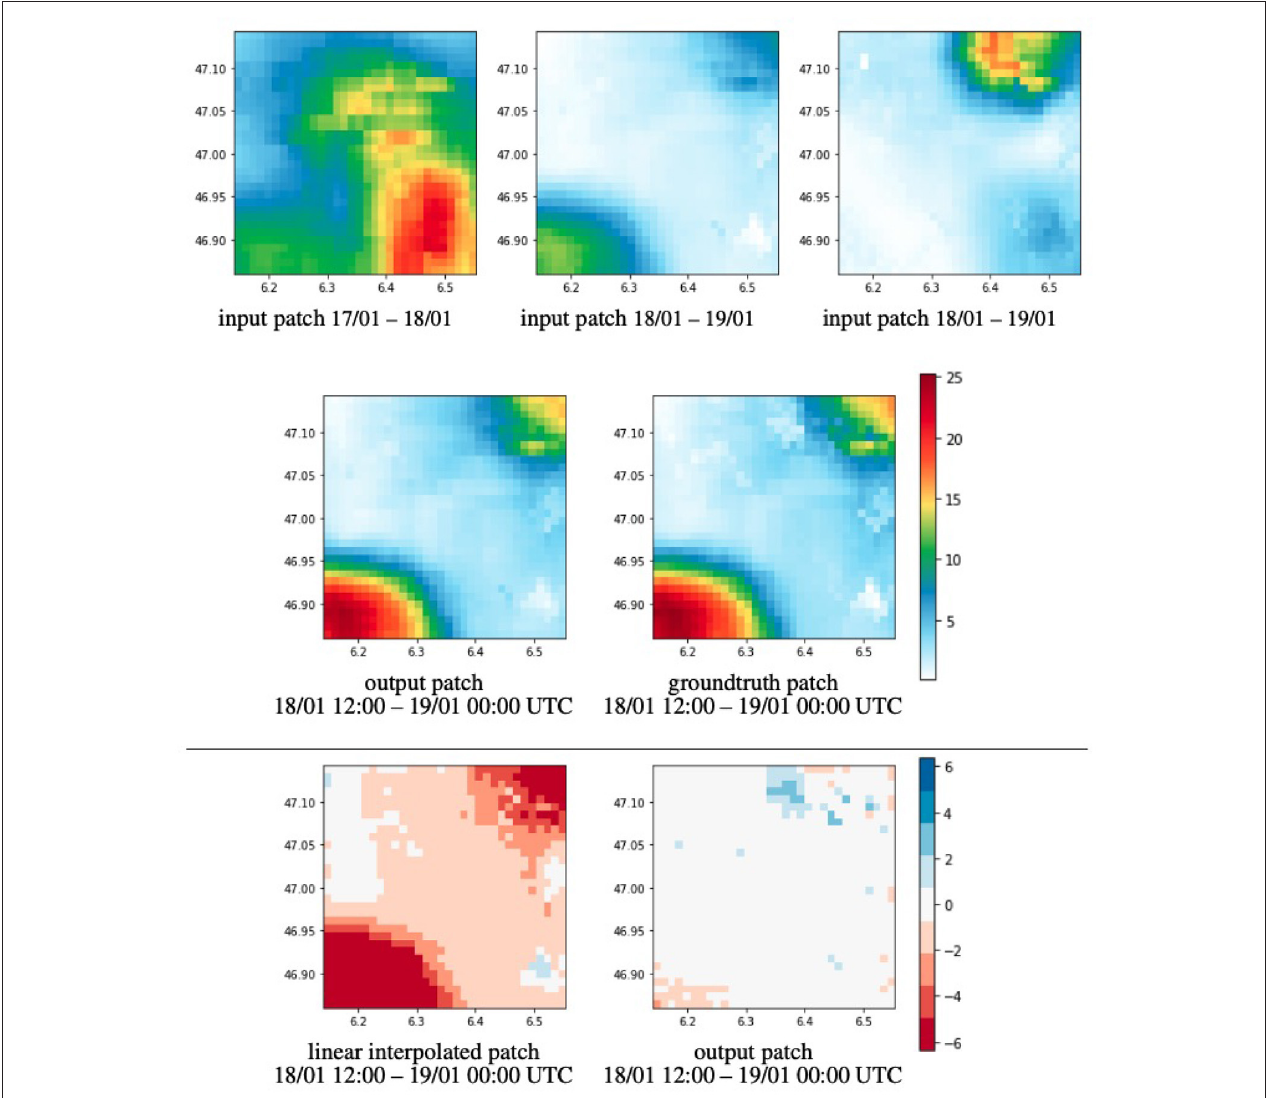
FIGURE 8 | Downscaling results of observational precipitation from 24 h resolution to 12 h. Top row shows input patches ranging from 1 day 12:00 UTC to the other 12:00 UTC. Middle row shows the predicted output patch and the groundtruth. Last row compares the baseline and predicted error maps relative to the groundtruth (MSE kg/m 2 ). Our method learns to scale the amount of precipitation dependent on the time we estimate. Our method can reduce the MSE from 14.251 to